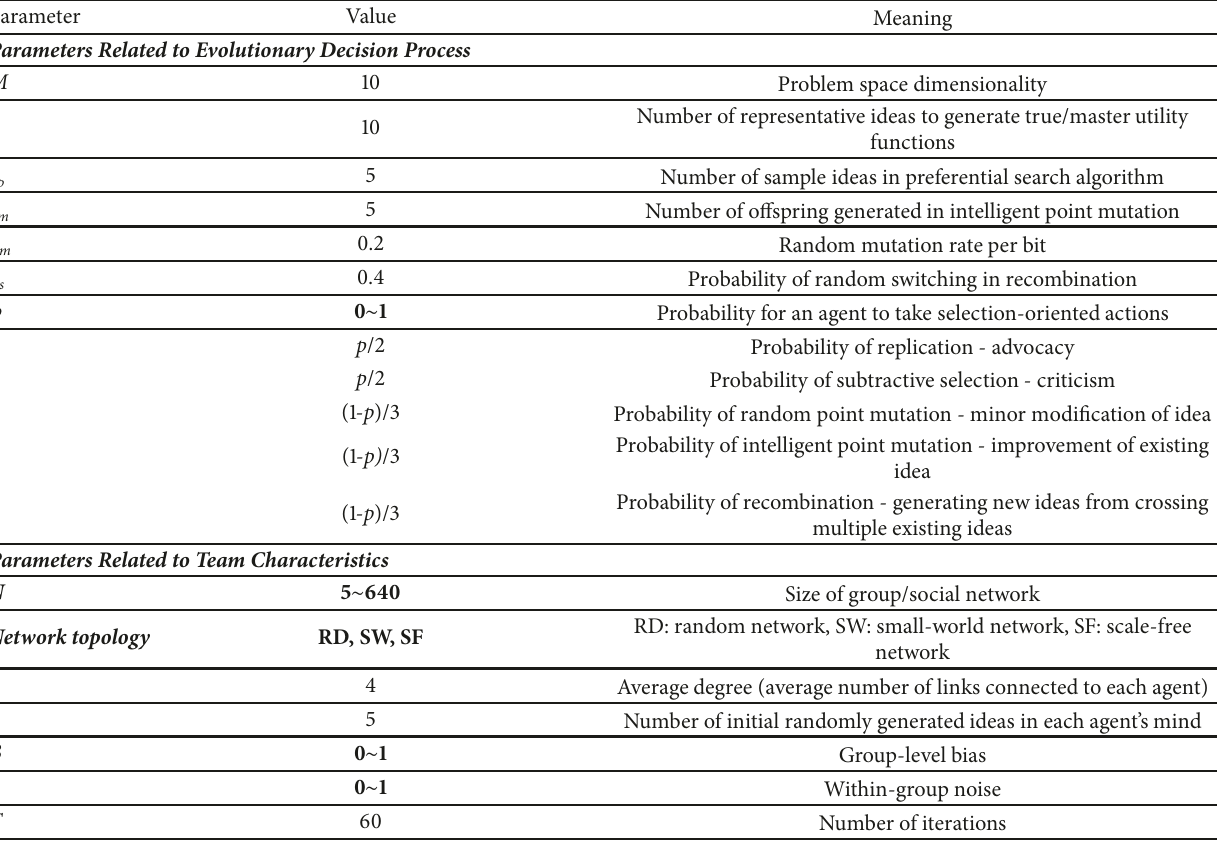
Table 2: Parameters and